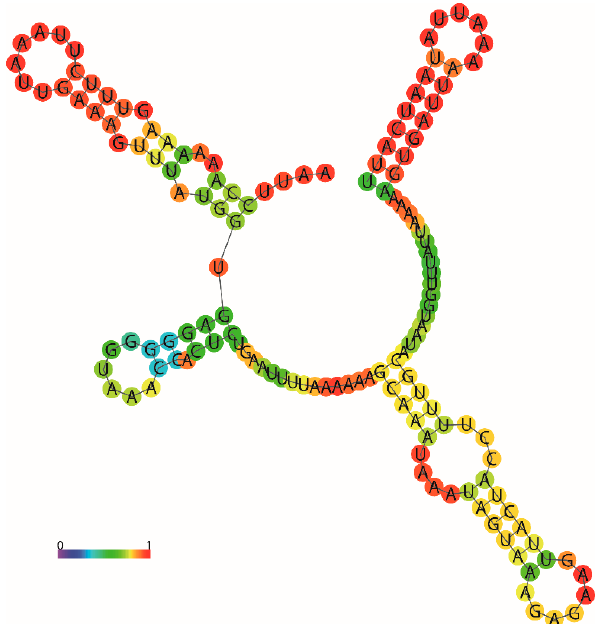
Figure 2. Mitochondrial DNA control region secondary structure of P. bilineatus , built using the Predict a Secondary Structure Web Server [35]. The structure is colored by base-pairing probabilities. For unpaired regions, the color denotes the probability of being unpaired.